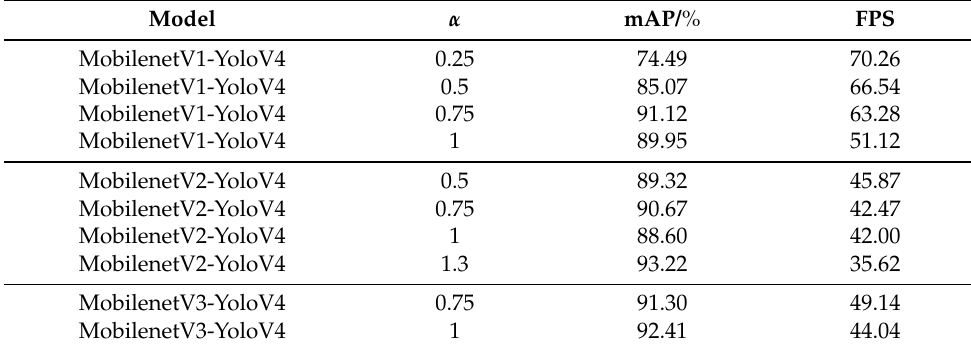
Table 3. The influence of different adjustment factors on the test